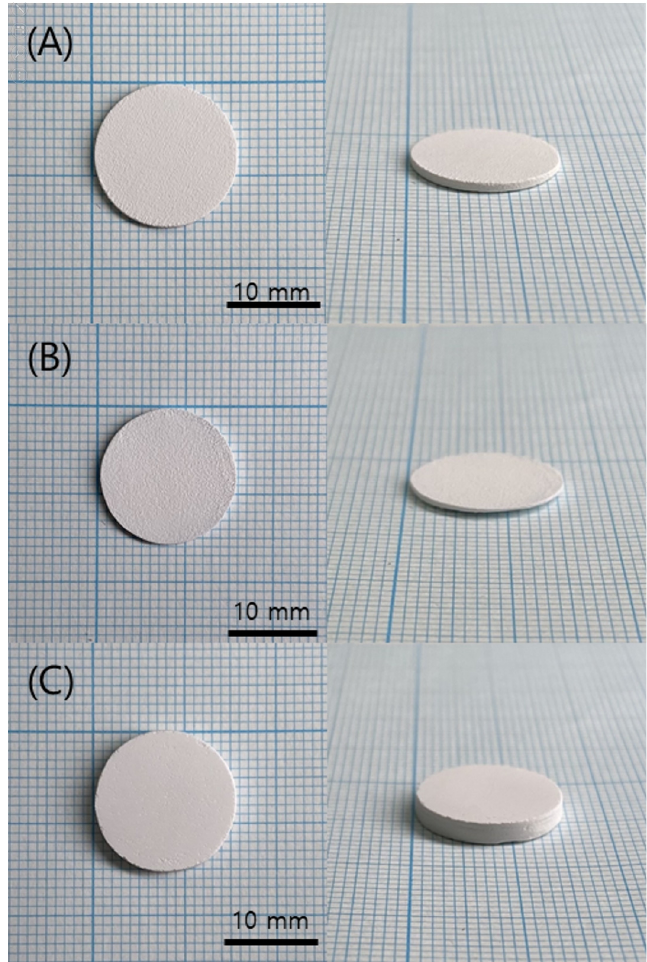
Figure 17. Green body specimens according to various pattern types: ( A ) square and line pattern; ( B ) big square pattern; ( C ) micro square pattern.